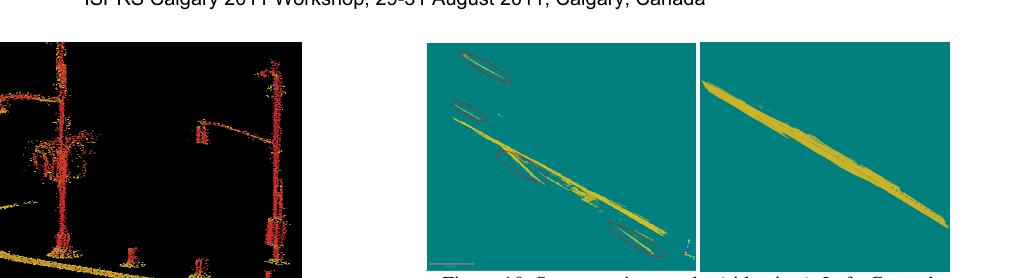
Figure 10. Segmentation results (side view). Left: Ground segment-phase three. Right: Ground segment-phase four.